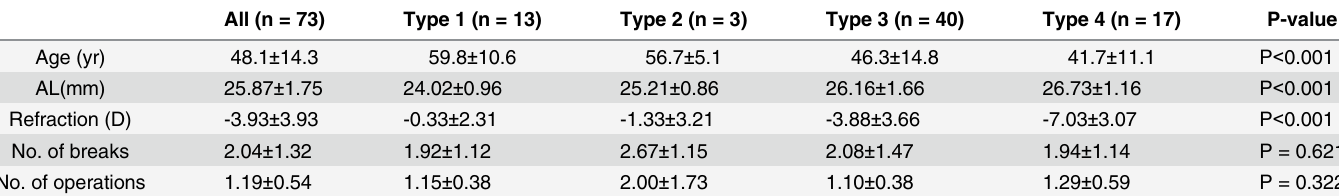
Table 2. Comparison of age, axial length, refractive status and number of breaks between the 4 groups.